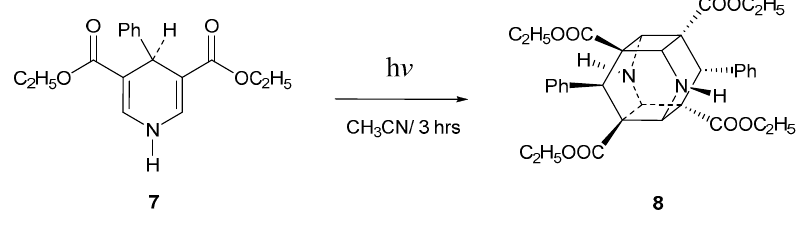
Scheme 4. Formation of cage structure 8 .